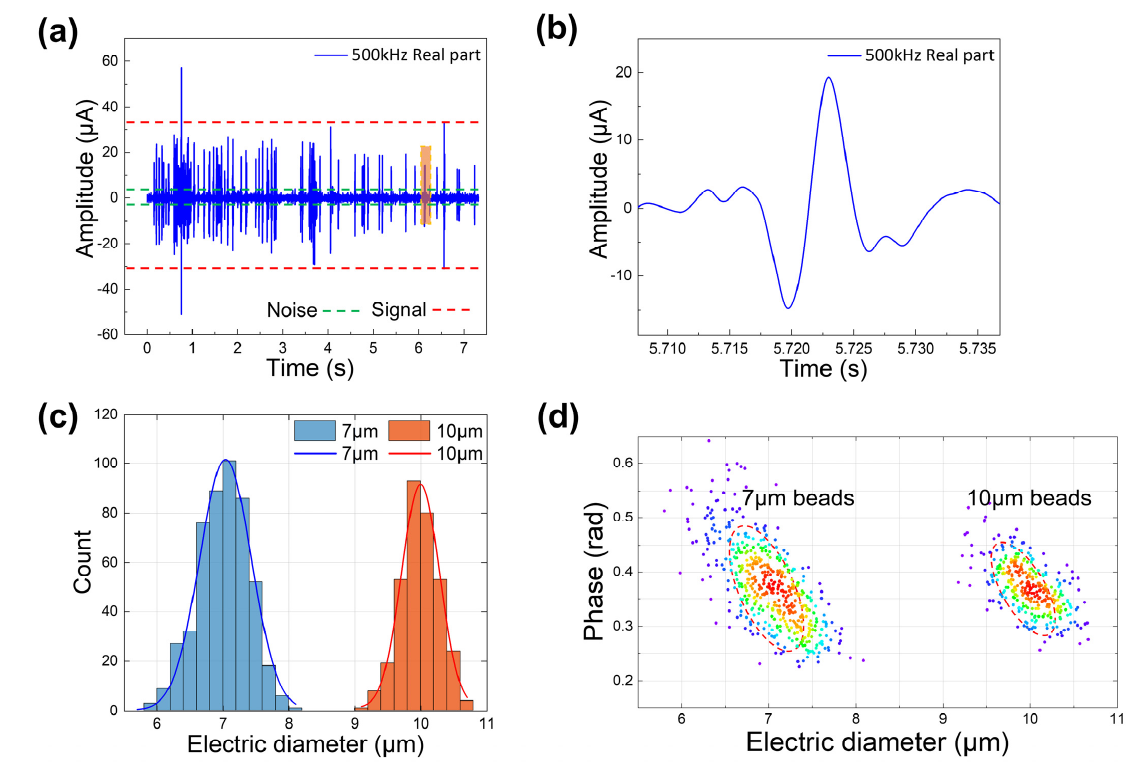
Figure 6. ( a ) Differential current signal for the 7 μ m and 10 μ m beads under the 1V AC voltage with a 500kHz frequency. The section between the dotted red lines represents the signal and the section between the dotted green lines represents the noise. ( b ) A differential current signal of a single particle passes through the detection region. ( c ) Histograms and Gaussian fitting curves of the electric diameter of 7 μ m and 10 μ m beads after calibration. ( d ) Density map of the electric diameter of the 7 μ m and 10 μ m beads after calibration.